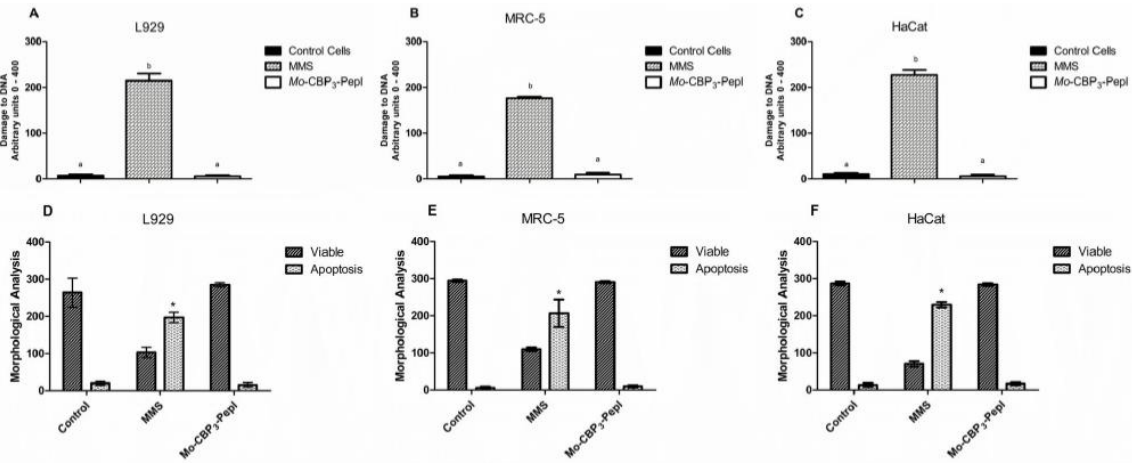
Figure 1. Assessment of toxicity of Mo -CBP3-PepI to human cell lines. ( A ) L929, ( B ) HaCaT, and ( C ) MRC-5 lines were incubated with synthetic peptide at a concentration of 1 mg mL − 1 to evaluate the damage to DNA by comet assay. ( D – F ) Cell lines were incubated with peptides as described and evaluated for viable cells and cells in apoptosis. MMS (4 × 10 − 5 M) was employed as a positive control for cell toxicity, and healthy cells as a negative control for toxicity. Data are shown as mean ± standard deviation of three independent experiments. * p < 0.05. Small letters indicate statistical significance. Another experiment to evaluate damage and fragmentation of DNA caused by Mo - CBP 3 -PepI was evaluated by Comet assay (Figure 2) against the same cell lines and at the same concentration. The assay revealed that the DNA of cells treated with peptides pre- sented no damage. In contrast, cells treated with MMS presented with completely dam- aged DNA (Figure 2). These results assure that the peptide is either safe or presents a low risk for human cells. Other peptides have presented high toxicity to human red blood cells and other human-type cells, such as WRL-68 (liver cells) and NL-20 (lung cells) [23].